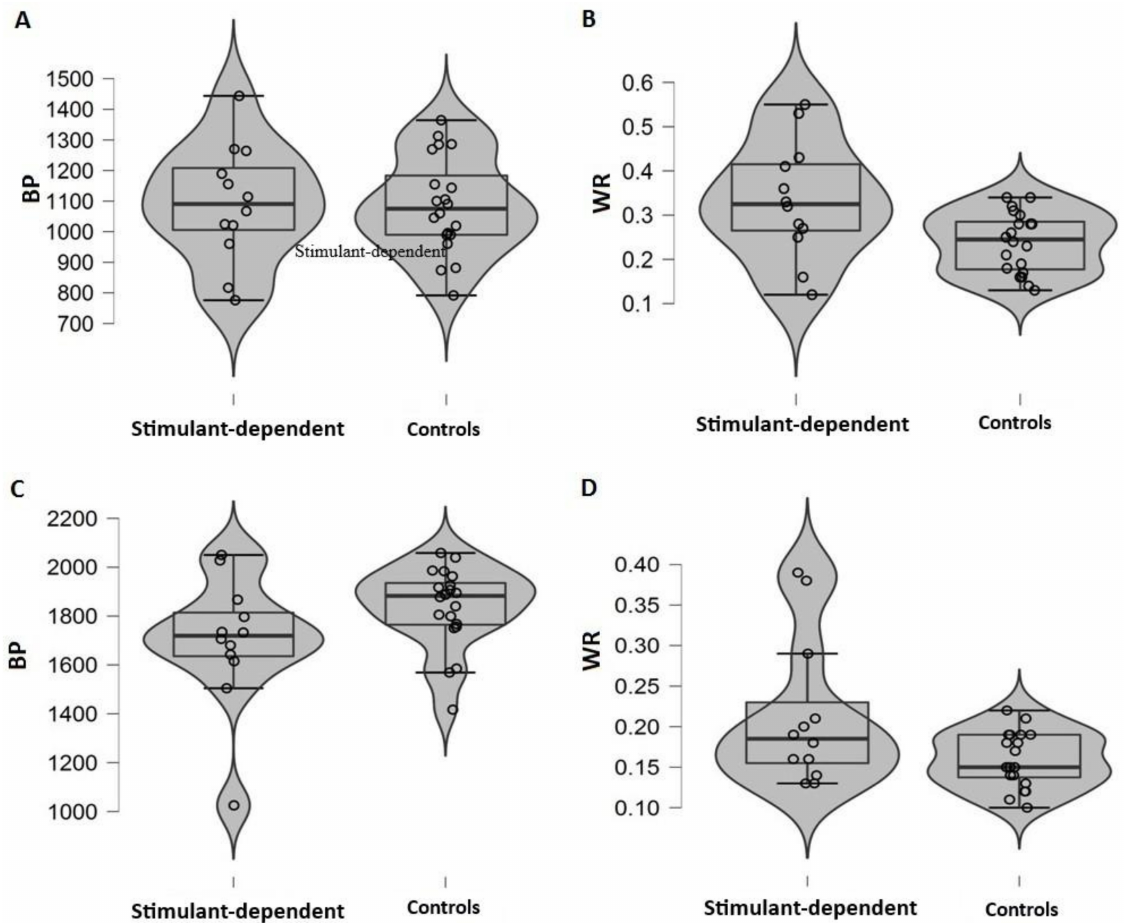
Figure 2. ( A , C ) Bisection Point (PSE) and ( B , D ) Weber ratio (WR) for stimulant dependent and controls. Each dot represents a participant. The thicker line represents the median and the box represents the interquartile range. The grey area represents the kernel density estimation to show the distribution shape of the data. Wider sections of the violin plot represent a higher probability that members of the population will take on the given value; the skinnier sections represent a lower